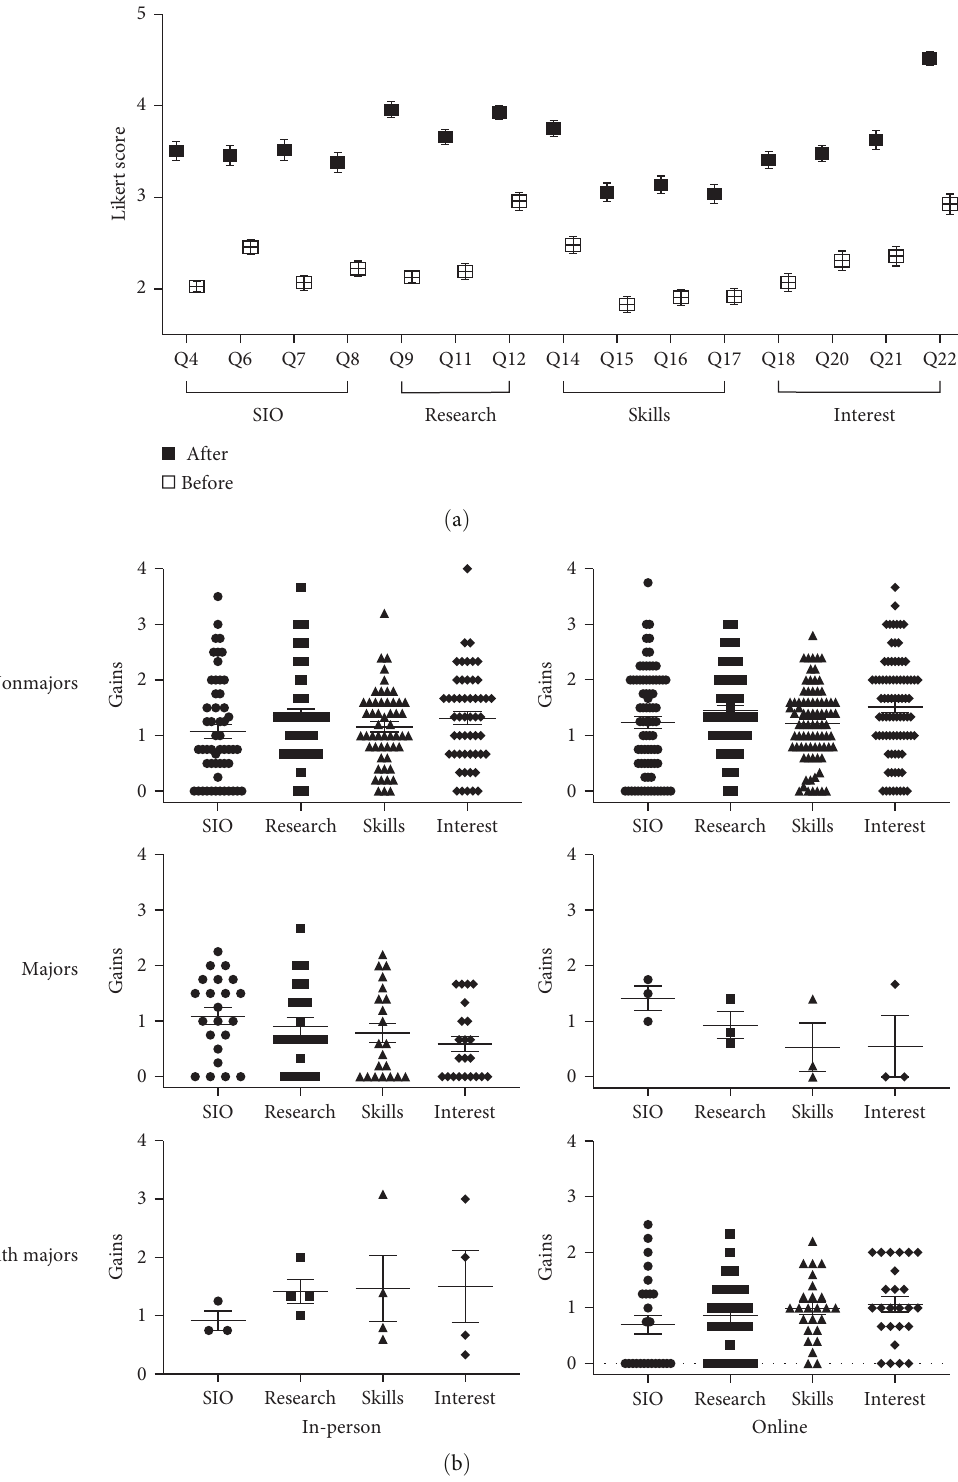
F IGURE 2: (a) “ Before ” and “ after ” survey scores (mean and SEM) of the individual survey questions for all students. (b) Scatter plot of survey score gains (mean and SEM) binned by themes (SIO, Research, Skills, and Interest) for the three majors in online and in-person modalities. Gain was calculated as “ after ” score minus “ before ”